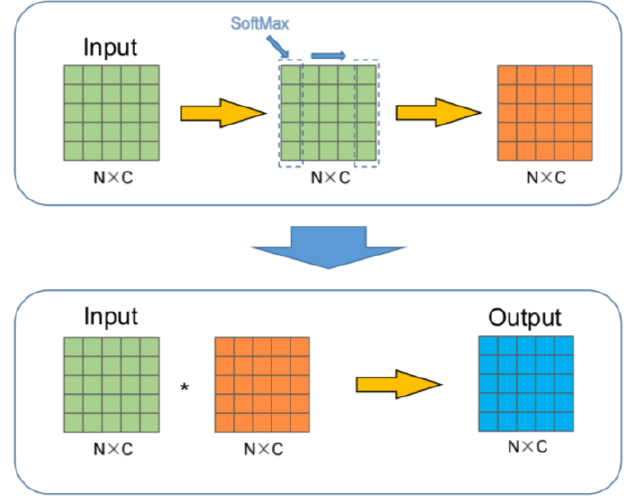
Figure 5. Process of block attention. In MSBA method, N = 6 and C = 2048.